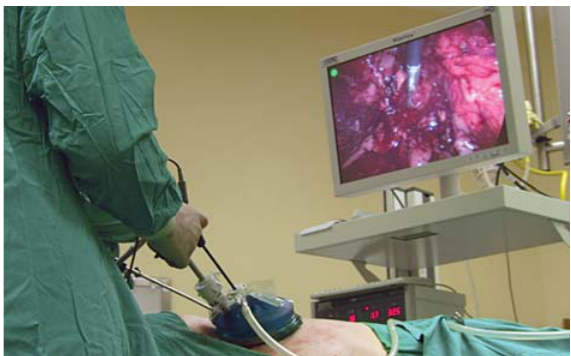
Figure 2 – The Gelport™ in use. Note that the surgeon stands on the abdominal side of the patient, which is unusual for retro- peritoneal